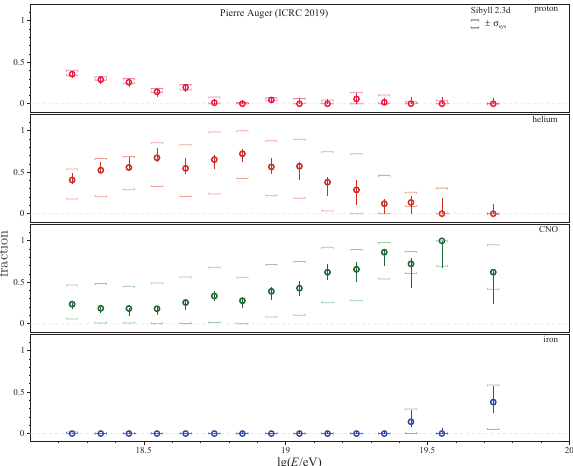
Figure 1. The fractions of H, He, N, and Fe that best fit the Auger X max distributions, using templates produced by the Sibyll 2.3d high-energy interaction model.